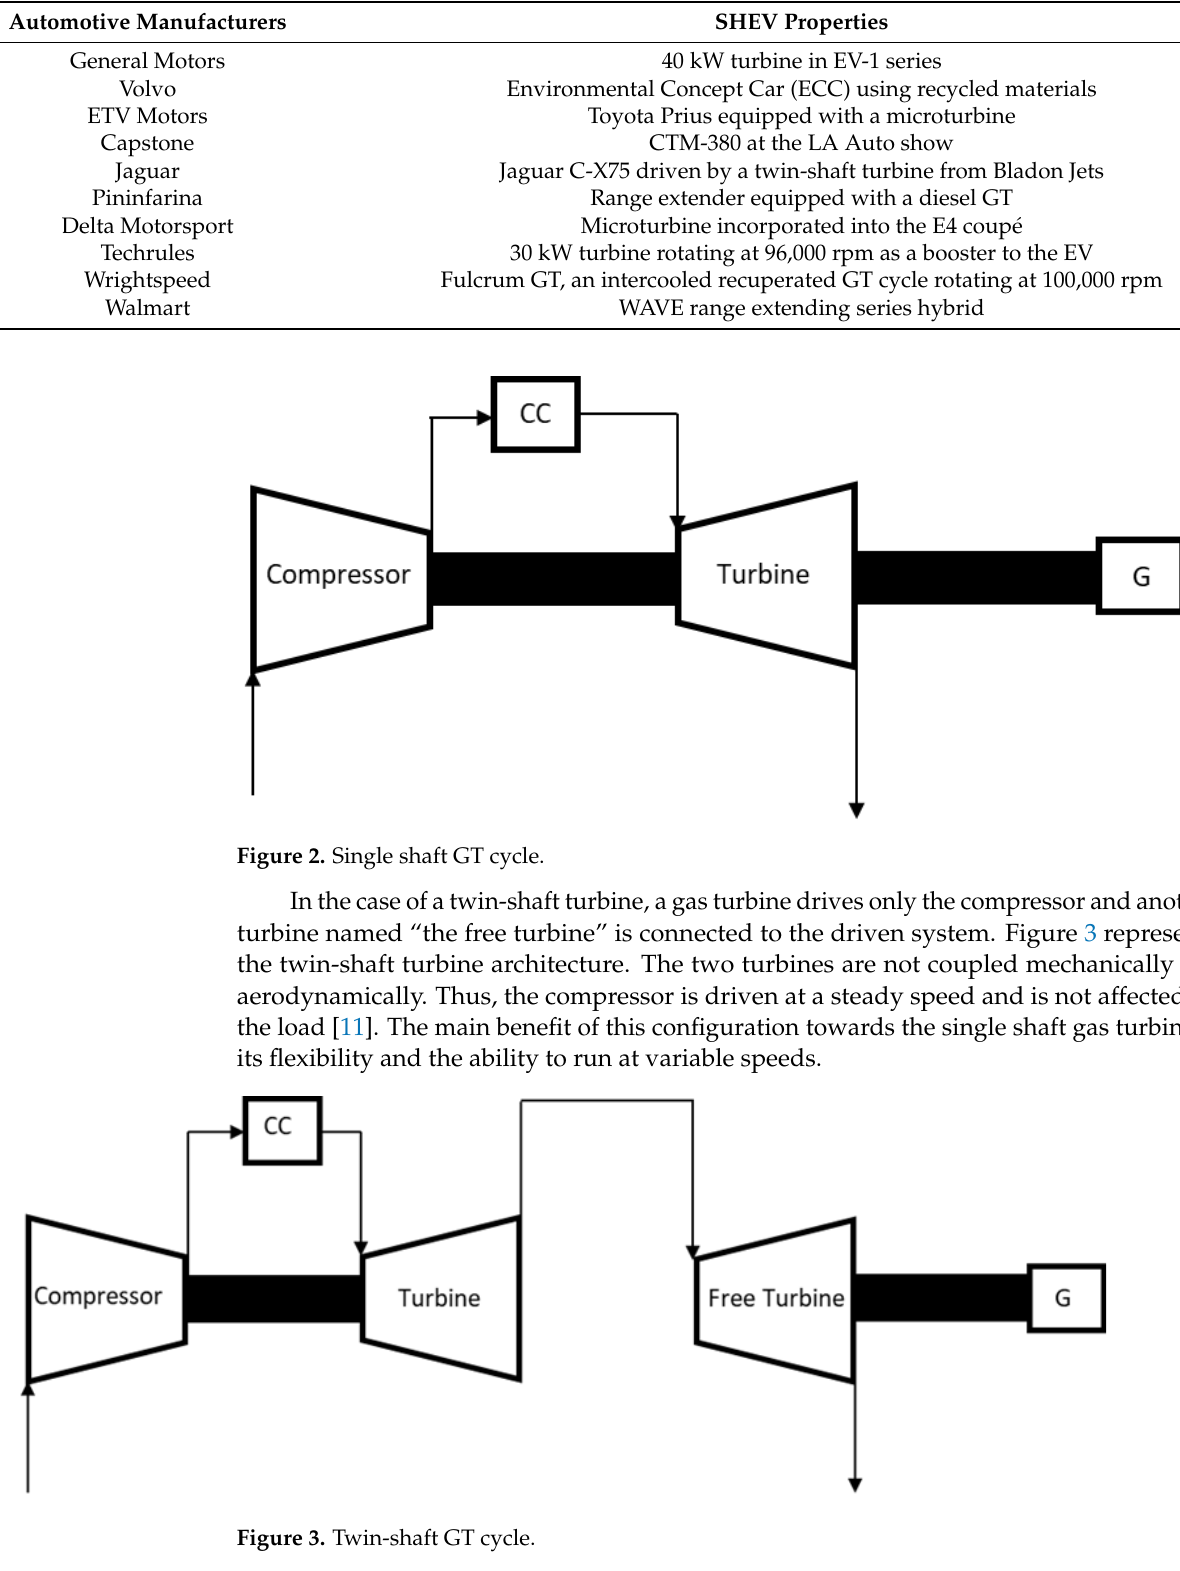
Figure 3. Twin-shaft GT cycle.